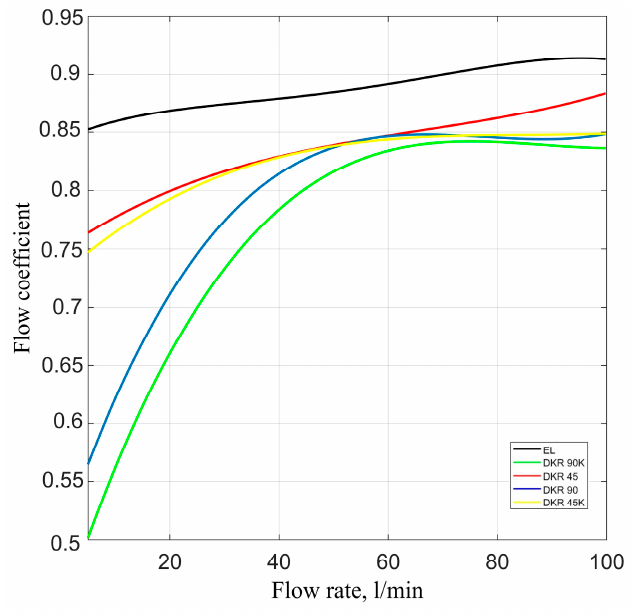
Figure 9. Fluid pressure losses at the angular fitting connections.